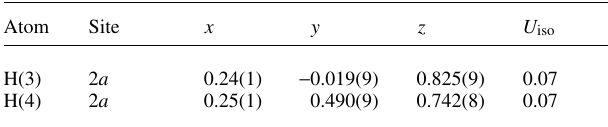
Table 2. Atomic coordinates and displacement parameters (in Å 2 ) . Table 2. Continued